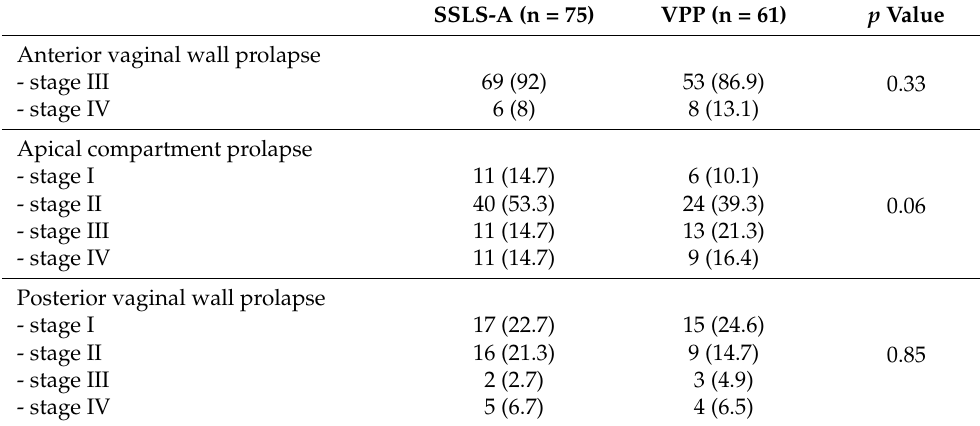
SSLS-A: anterior sacrospinous ligament suspension; VPP: vaginal patch plastron; POP-Q: pelvic organ